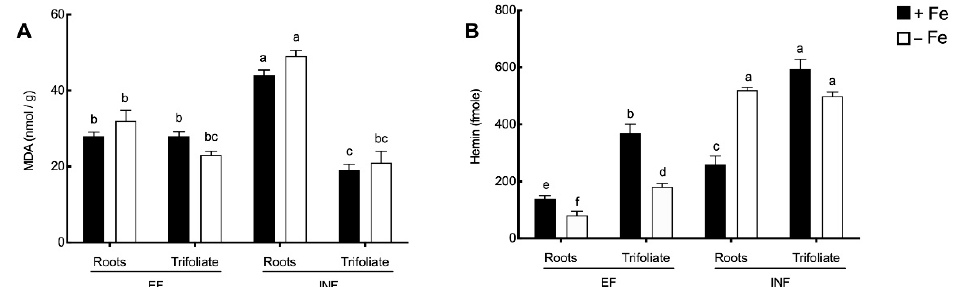
Figure 5. Malondialdehyde (MDA) concentration (nmol/g) and hemin concentration (fmole) in the roots and trifoliate leaves of efficient (EF) and inefficient (INF) soybean lines grown under Fe sufficiency (+Fe, 20 µM) or Fe de fi ciency ( − Fe, no Fe) for 14 days under hydroponic conditions. ( A ) MDA; ( B ) hemin concentrations. Data are means ± SE; different letters indicate significant differences ( p < 0.05) by ANOVA with Tukey correction test.